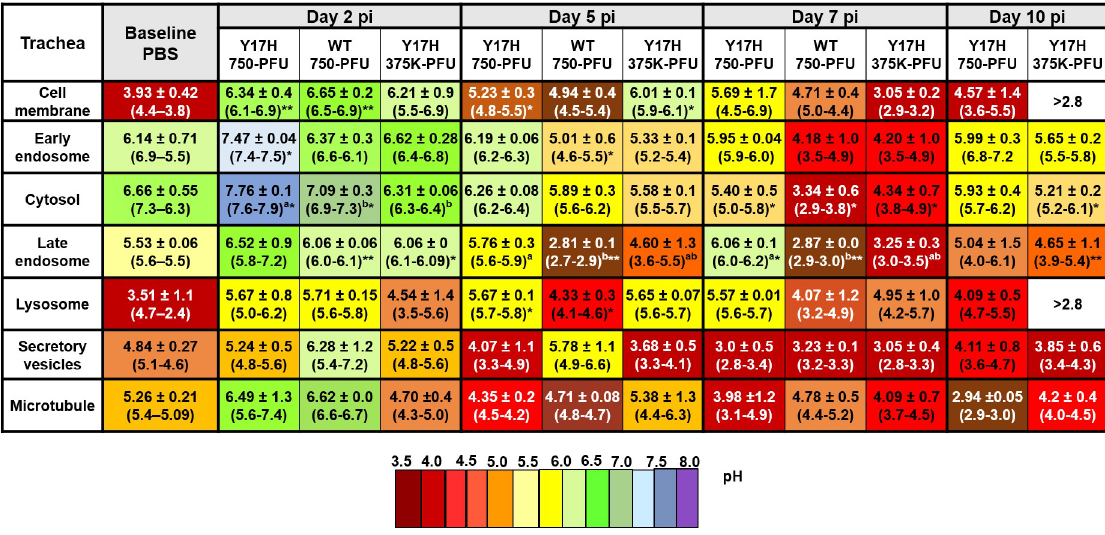
Fig 8. Intracellular pH values of individual uninfected and infected live epithelial cells isolated from the tracheal tissues of DBA/2J mice. Mice were intranasally inoculated, and cellular pH values were determined as described in Fig 6.